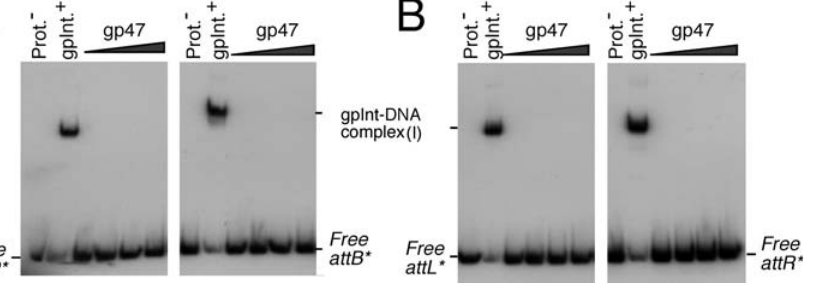
Figure 6 . DNA-Binding Properties of Bxb1 gp47 (A and B) The ability of gp47 to bind attP, attB, attL, and attR was determined using native gel electrophoresis. Binding of gp47 or gpInt to attP and attB (A) or attL and attR (B) was performed with either gpInt (0.072 l M), or increasing concentrations of gp47 (0.45, 0.89, 1.78, and 3.56 l M). DOI: